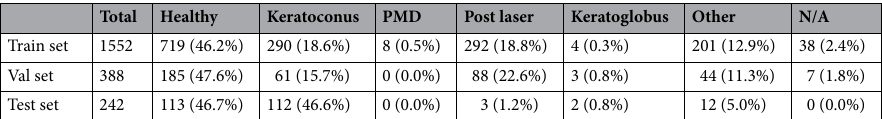
Table 1. Class distribution and count in the cornea scans dataset showing the imbalanced classes in the screening data.